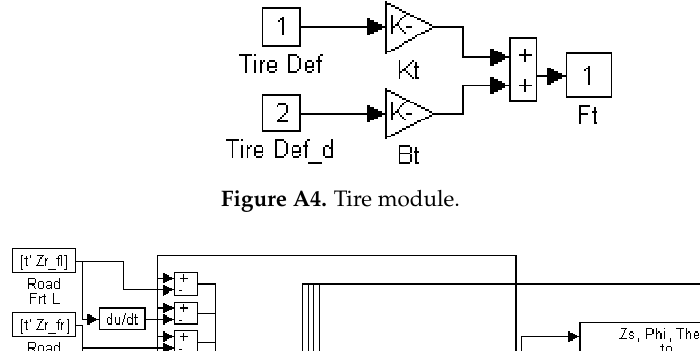
Figure A3. Semi-active control module using the continuous double sky-hook algorithm with a nonlinear damper.